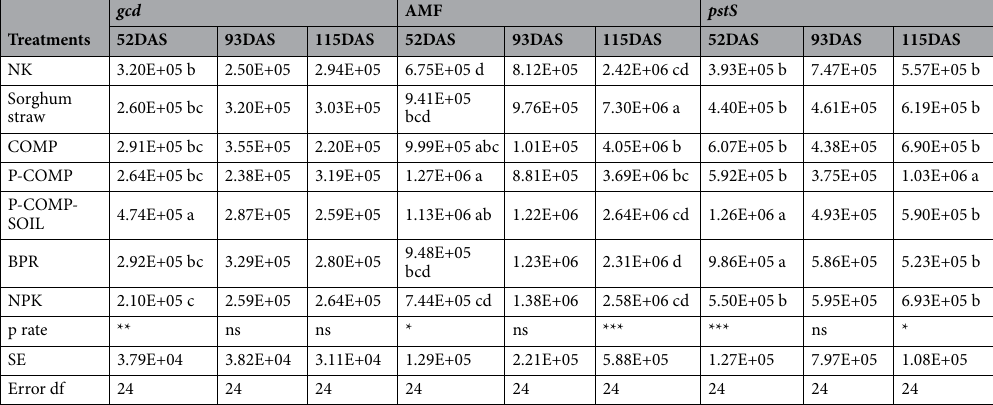
Table 4. One-way ANOVA (treatment) of gcd , AMF, pstS genes over the three sampling periods. NK Without phosphate or compost addition, COMP Sorghum straw-based compost, P-COMP Sorghum straw-based compost + BPR, P-COMP-SOIL Compost made from sorghum straw, BPR, and sorghum rhizosphere soil, BPR Burkina phosphate rock, parameter values assigned by different letters differ significantly (**) at p < 0.01 and significantly (*) at p < 0.05, ns Not significant at p < 0.05. SE Standard error, df Error degree of freedom, DMRT Duncan’s multiple range test, LSD least small difference, gcd Glucose dehydrogenase, AMF Arbuscular mycorrhizal fungi, pstS Phosphate-specific transporter, DAS Days after